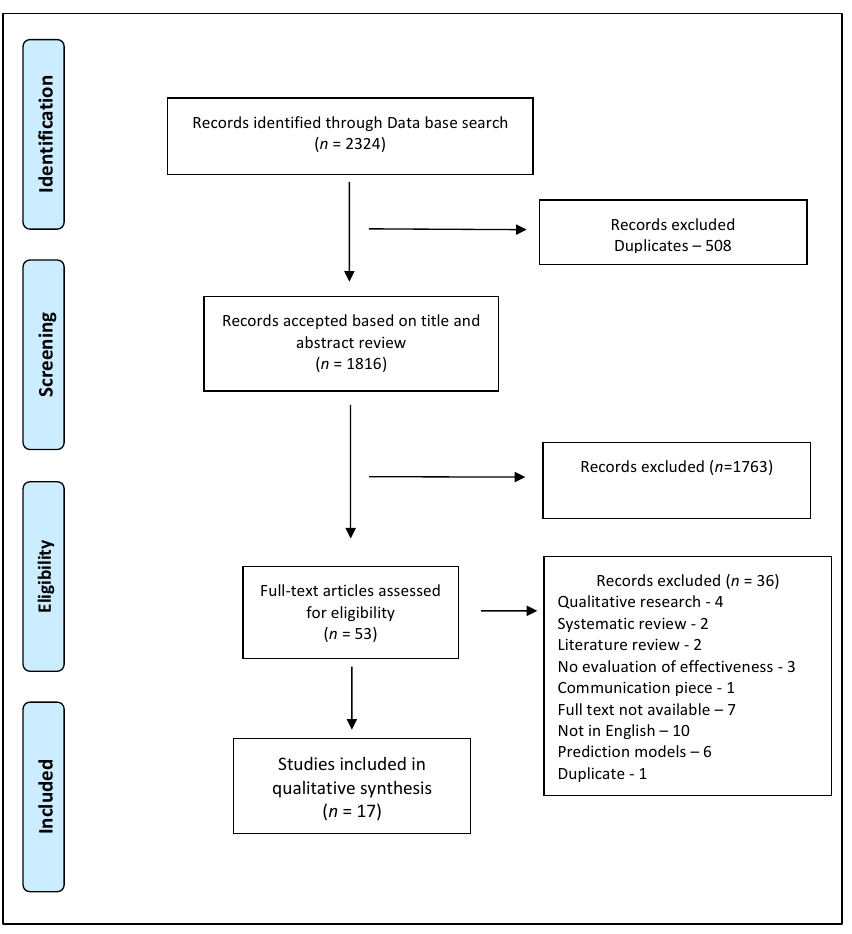
Figure 1. PRISMA flow chart highlighting the literature review.